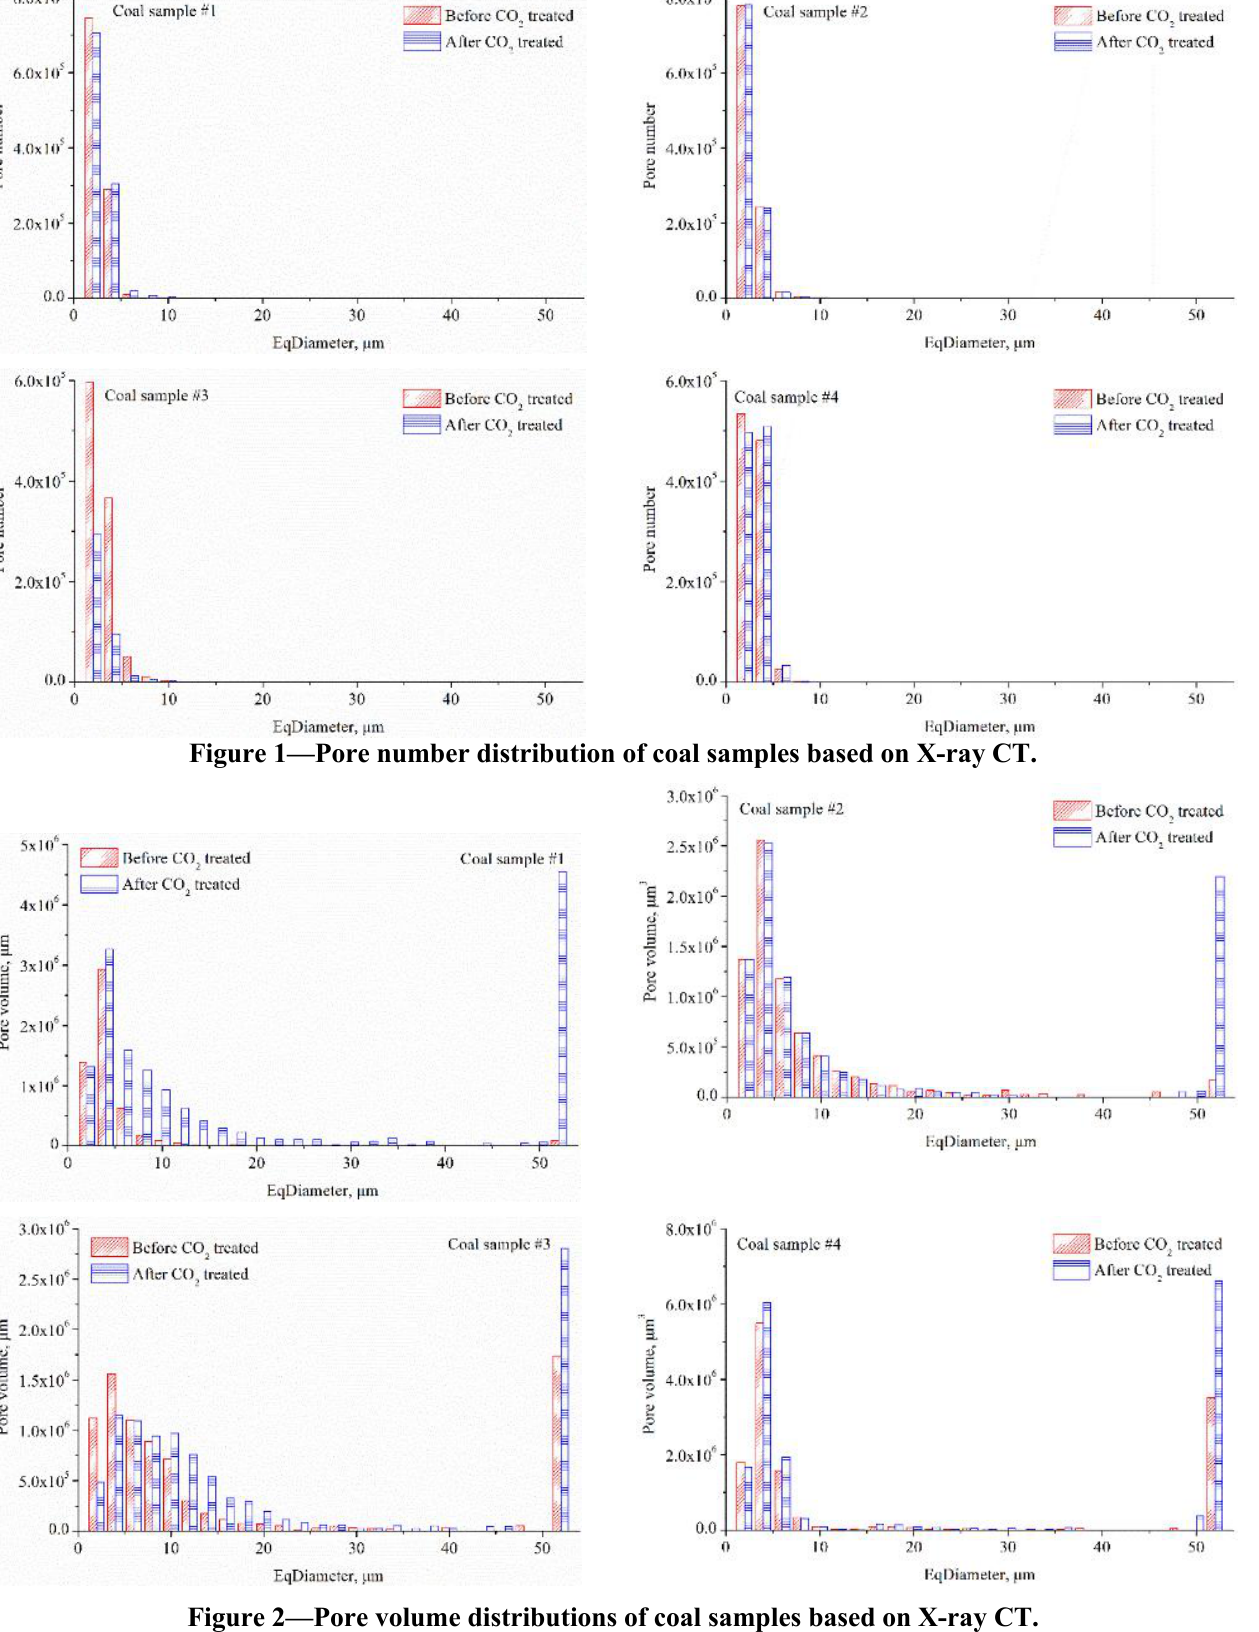
Figure 2—Pore volume distributions of coal samples based on X-ray